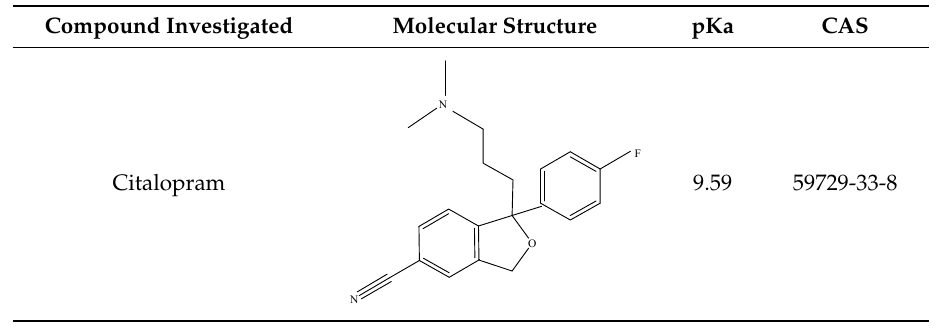
Table 1. Chemical structure and pKa [8] of citalopram (1-(3-dimethyaminopropyl-1-(4-fluoro-phenyl(-5- phthalancarbonitrile (CIT)).